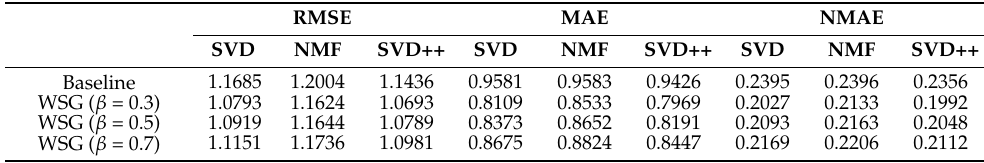
Table 7. RMSE, MAE, and NMAE values with and without L-CNN sentiment and genres-based model and different values of β on Amazon Movie dataset.